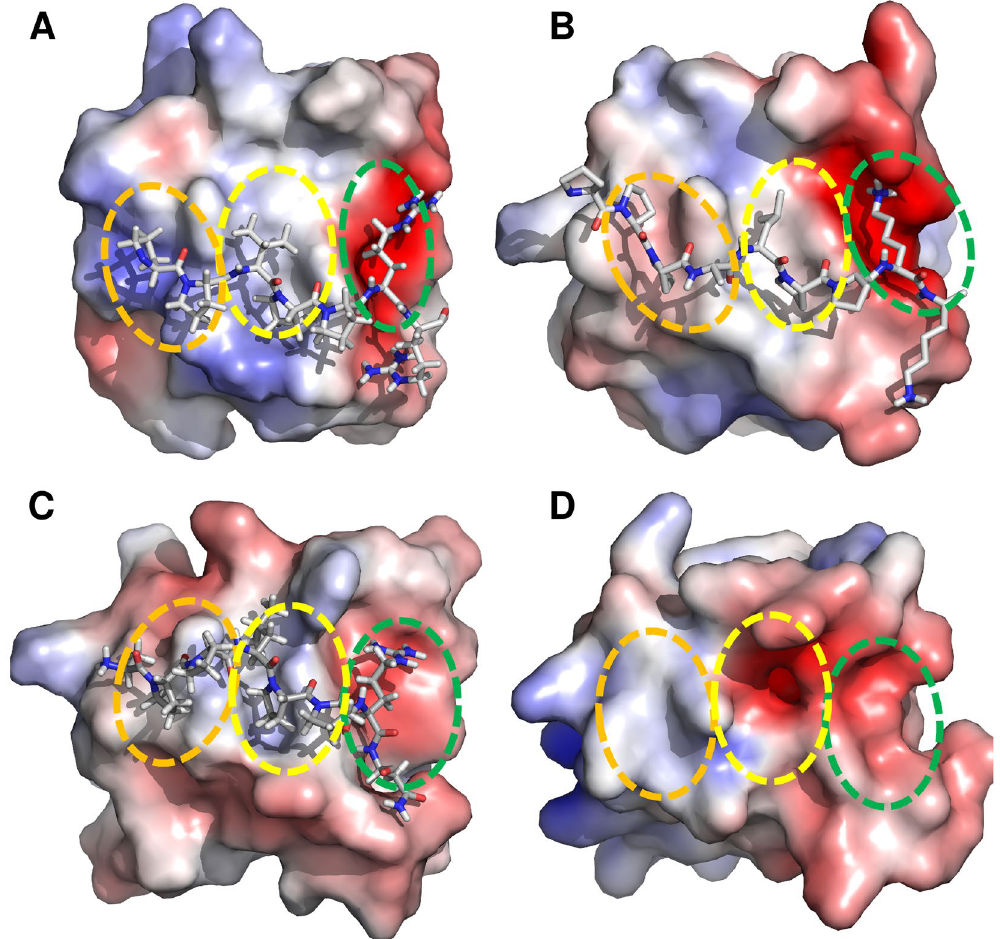
Figure 1. SH3 domains of proteins involved in the CAS signaling circuit. ( A ) (Grb2, PDB code 1AZE), ( B ) (Crk, PDB code 1CKA), ( C ) (Src, PDB code 1QWE), ( D ) (CAS, PDB code 1WYX). The first and second xP dipeptide-binding pockets are highlighted with orange and yellow circles, respectively. The third pocket/zone is highlighted with a green circle. SH3 domains are shown in electrostatic potential surface representation (APBS colored in the range from − 5 to +